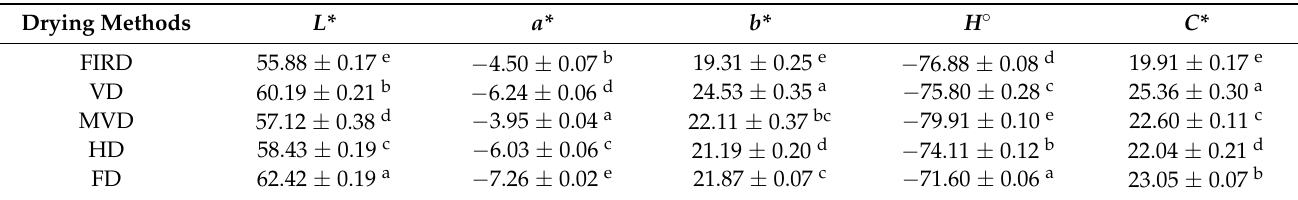
Table 1. Colors of different dried